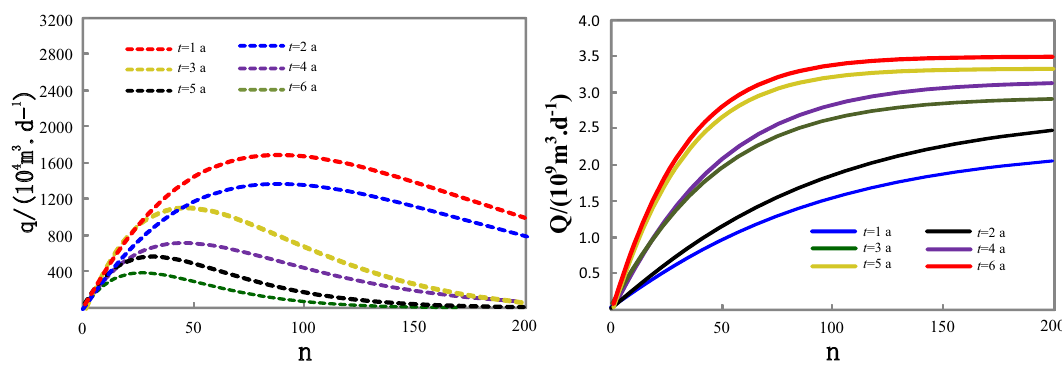
Fig. 5 The curves of flow rate and cumulative production versus well